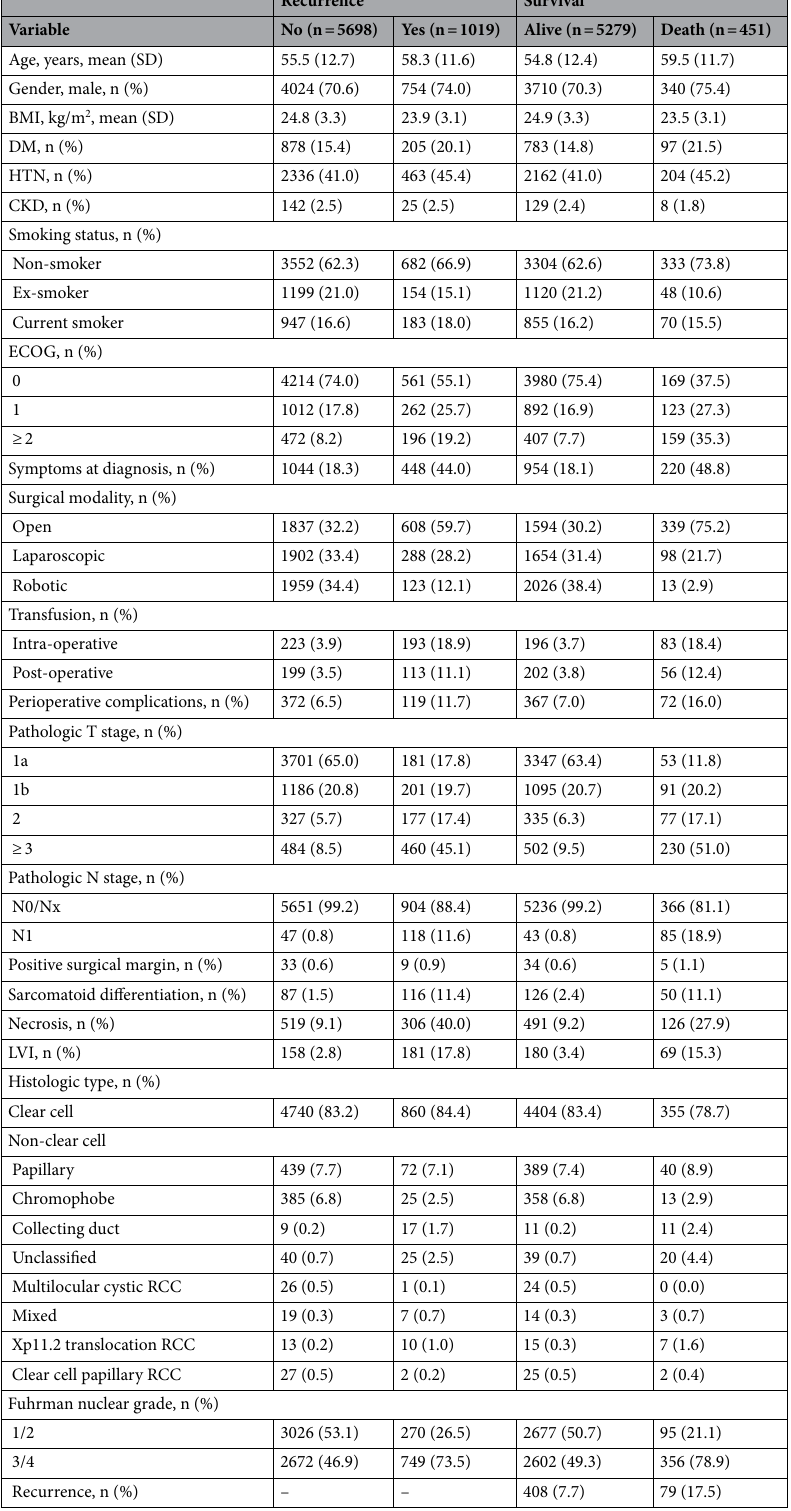
Table 2. Baseline